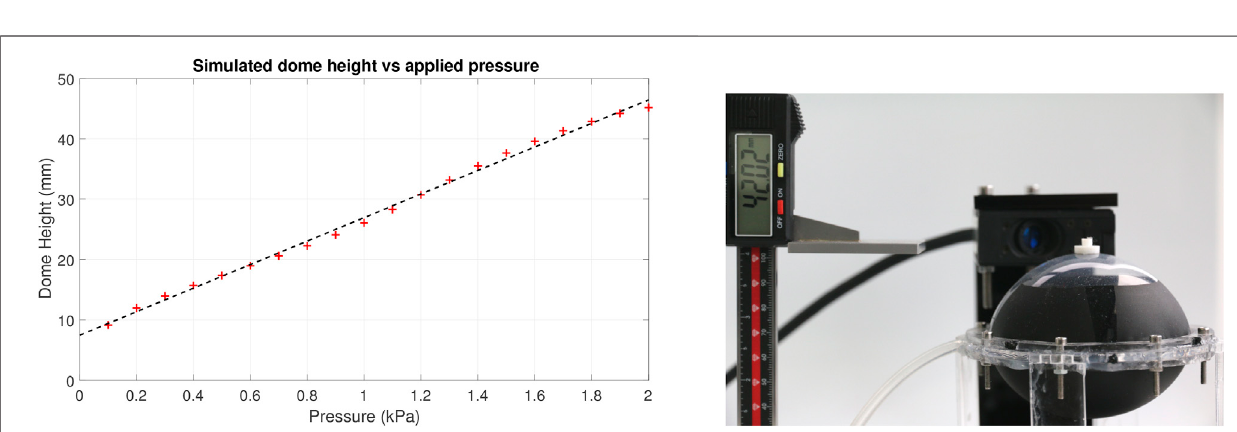
Frontiers in Robotics and AI |